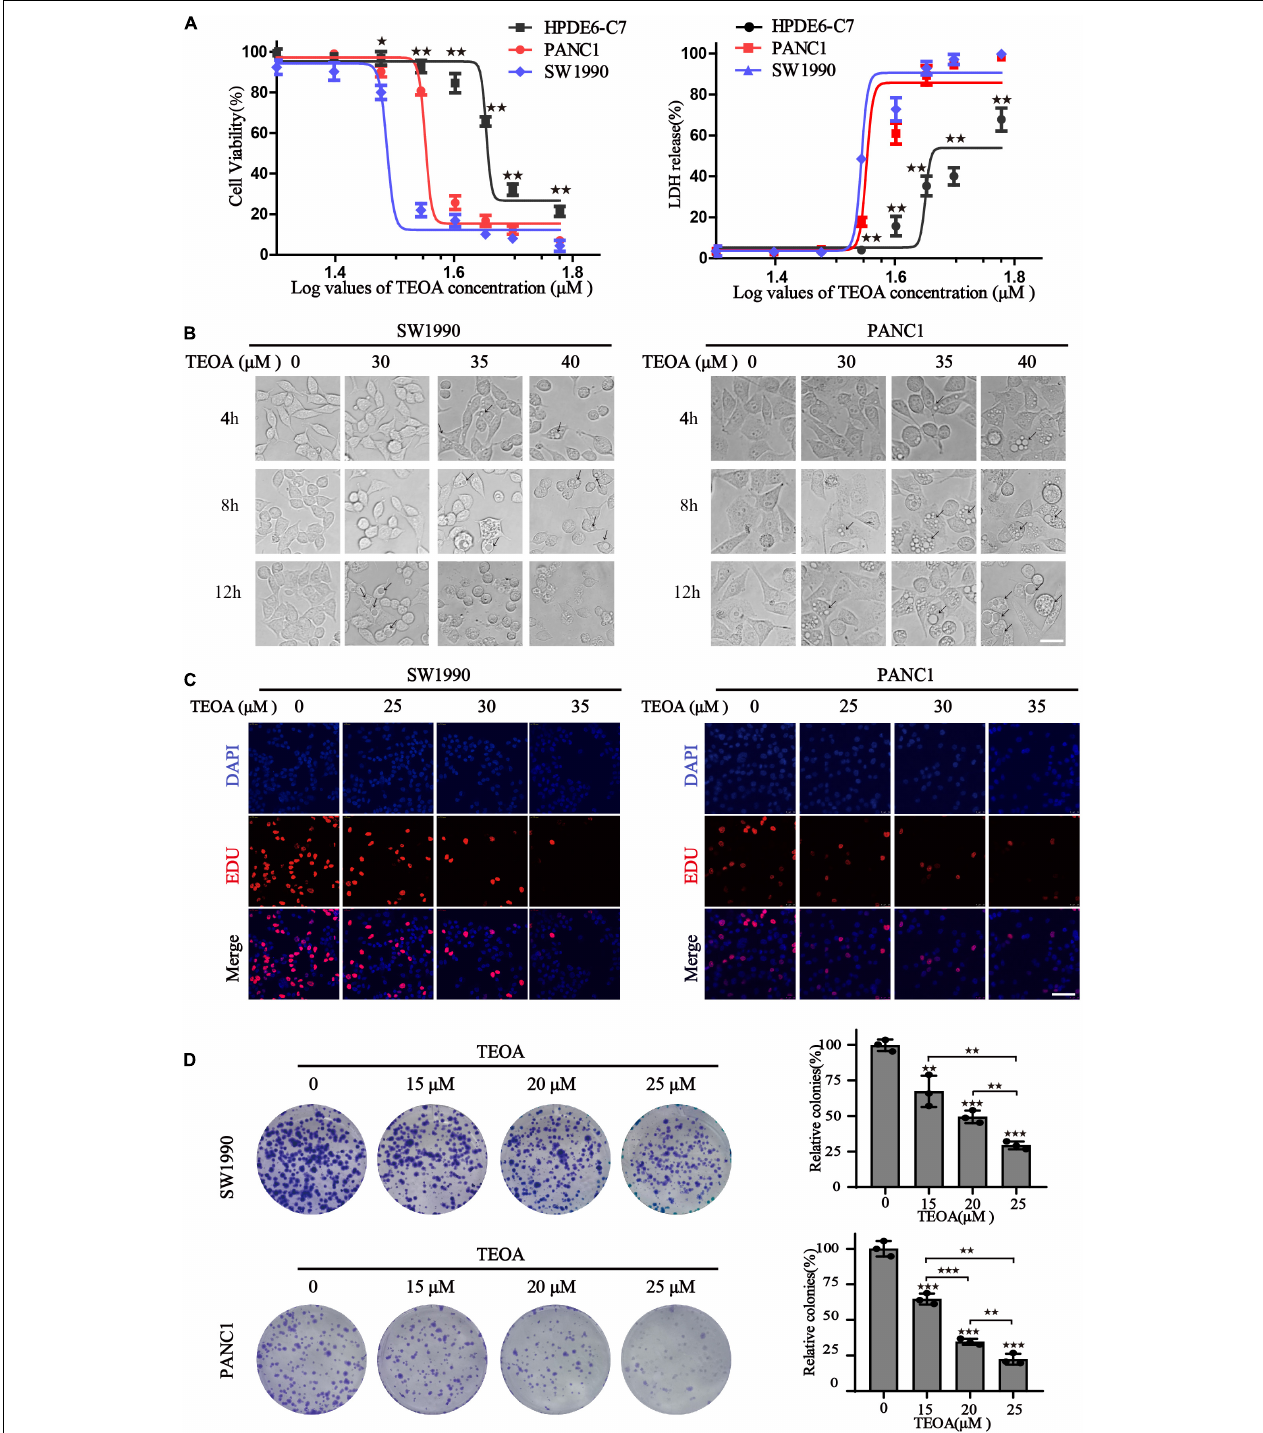
FIGURE 1 | TEOA induced relative selective cytotoxicity of human pancreatic cancer cells. (A) HPDE6-C7, SW1990, and PANC1 cells were treated with various concentrations of TEOA (0–60 µ M) for 12 h. The cell viability was detected using CCK-8 assays (left). LDH activities of drug-treated cells were measured by LDH cytotoxicity assay (right). (B) Cells were treated with 30, 35, 40 µ M TEOA for 4 h, 8 h, 12 h and photographed by microscope. Scale bars 20 µ m. The arrows were used to mark the vacuolation changes. (C) Cells were treated with TEOA at 0, 25, 30, 35 µ M and cell proliferation was detected by EdU assay after 12 h. (D) Cell proliferation ability with long-term TEOA treatment was estimated by the colony formation assay, and colonies were analyzed on the right ( (cid:70) p < 0.05; (cid:70)(cid:70) p < 0.01; (cid:70)(cid:70)(cid:70) p < 0.001, between groups).